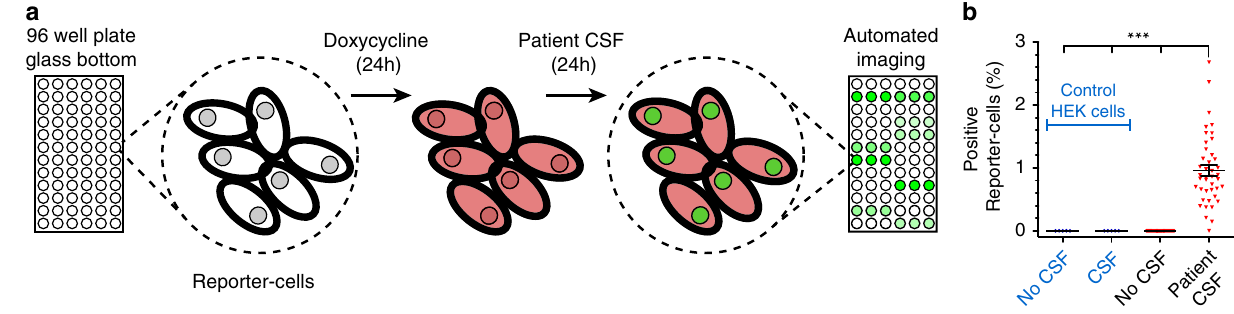
Fig. 7 Detection of transmittable h α Syn from human CSF samples. a Illustration of the experimental setup. Reporter-cells or wild-type HEK293 cells (control) were seeded onto glass bottom 96-well plates. FluoReSyn expression was induced by doxycycline for 24 h before they were exposed to human CSF or culture medium (control) for another 24 h. Finally, cells were fi xed and ~20 images of random and not overlapping locations were acquired automatically per well. The CSF from each patient was used at least in three different wells. b Quanti fi cation of cells with positive FluoReSyn signal. In total, results represent data from 126 wells of Reporter-cells receiving CSF samples from 42 individuals in technical triplicates, 102 negative control wells with Reporter-cells receiving culture medium, 15 wells of HEK293 cells receiving CSF samples from fi ve individuals in technical triplicates and 36 wells of HEK293 cells receiving culture medium. One-way ANOVA with multiple comparison Tukey test *** p < 0.001. Further correlations between the Reporter- cell activity and the clinical information of each patient are displayed in Supplementary Fig. 6 and Supplementary Table 1. Error bars represent the SEM, each data point represents the average from three replicas (wells) of an individual patient ’ s CSF. Source data is available as a Source data fi